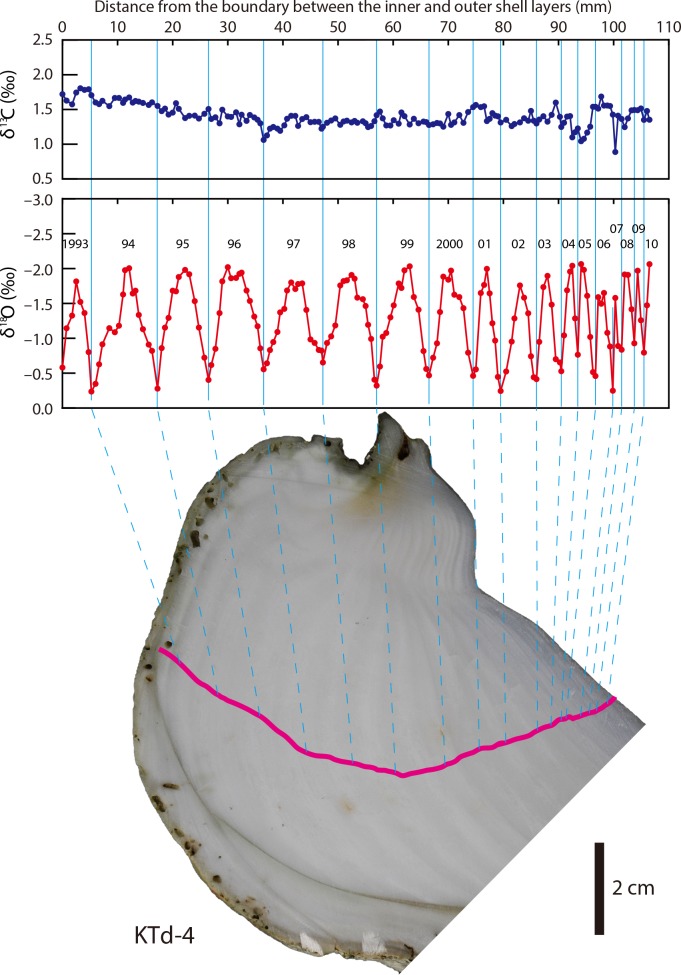
δ13Cshell and δ18Oshell profiles of a Tridacna derasa shell (KTd-4).Pink line indicates the sampling transect.